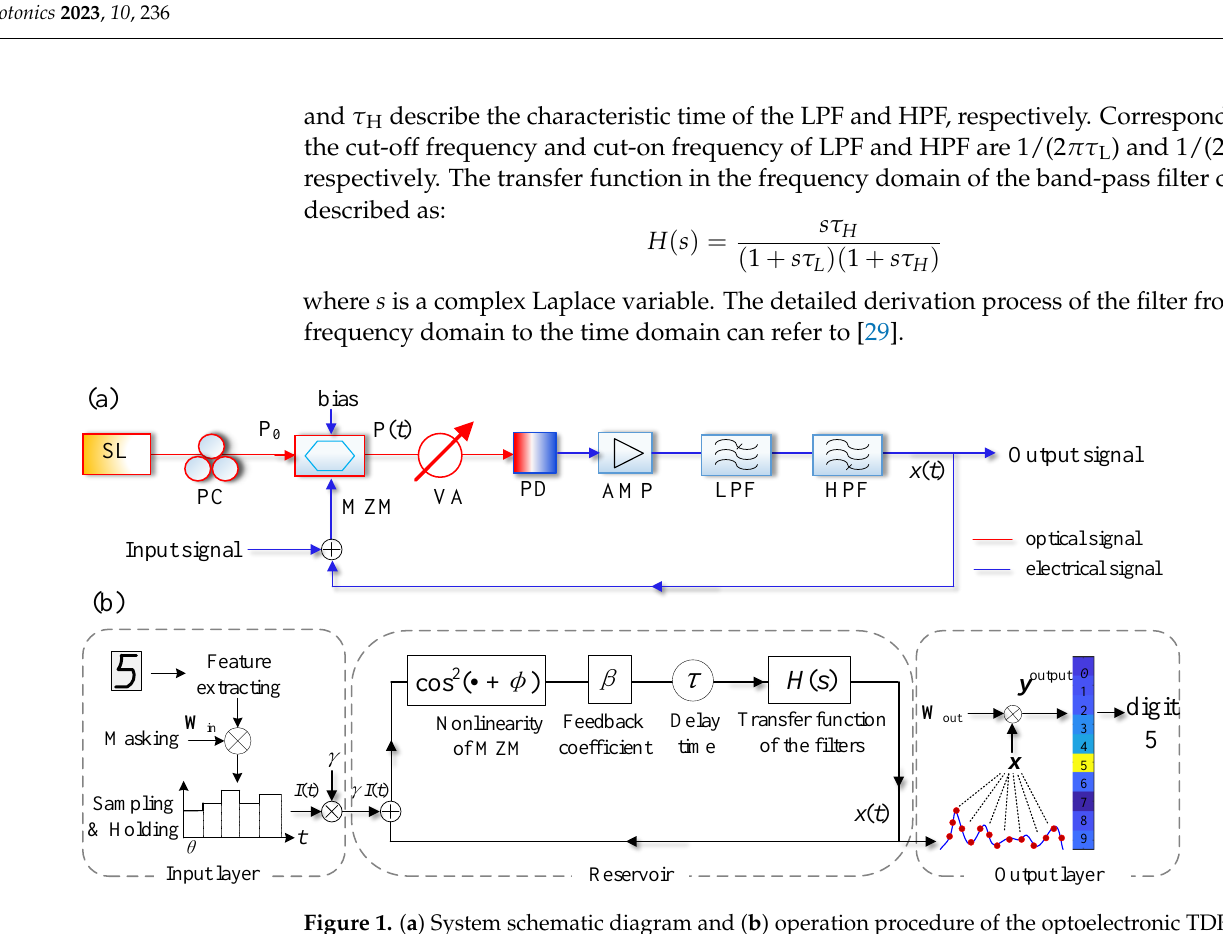
Figure 1. ( a ) System schematic diagram and ( b ) operation procedure of the optoelectronic TDRC. SL: semiconductor laser; VA: variable attenuator; PD: photo detector; AMP: electronic amplifier; LPF: low-pass filter; HPF: high-pass filter.